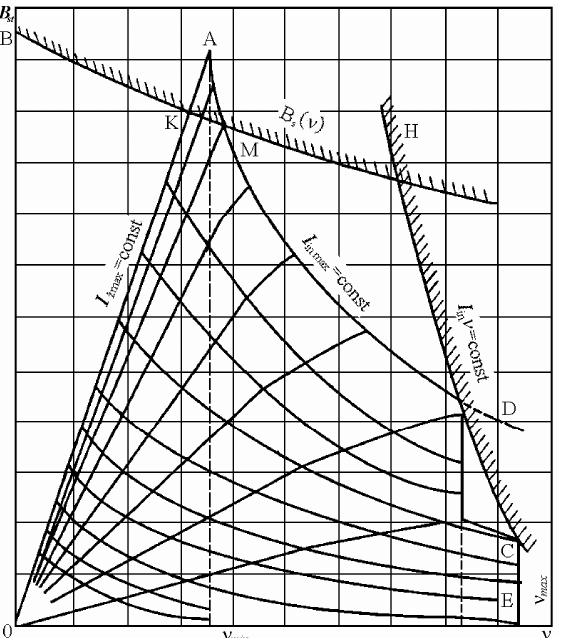
Fig 11. Braking characteristics of traction motor: OA is restriction imposed by the strongest excitation current; AD is restriction imposed by the strongest armature current; HC are ( ) vB restrictions imposed by commutation; is restriction s imposed by adhesion with rail